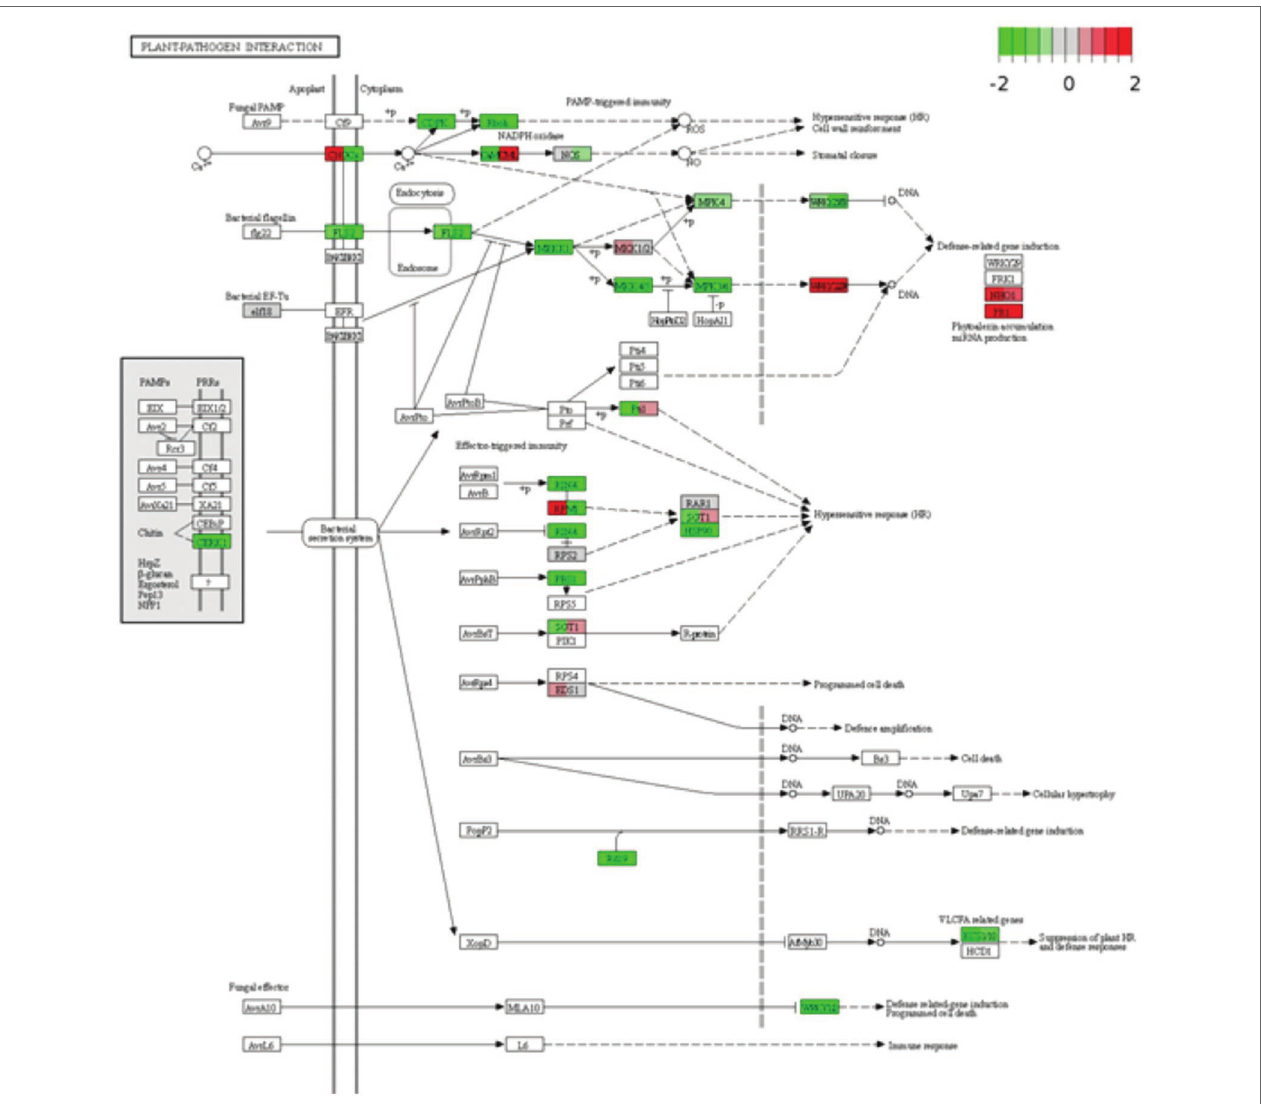
FIGURE 4 | Differentially expressed genes are involved in plant-pathogen interactions. Expression values of the DEGs are presented as log 2 Fold Change > 1 (red for upregulated, green for downregulated). The vertical columns represent the gene expression for samples QL3 24 h post-inoculation (hpi) and Theis 24 hpi from left to